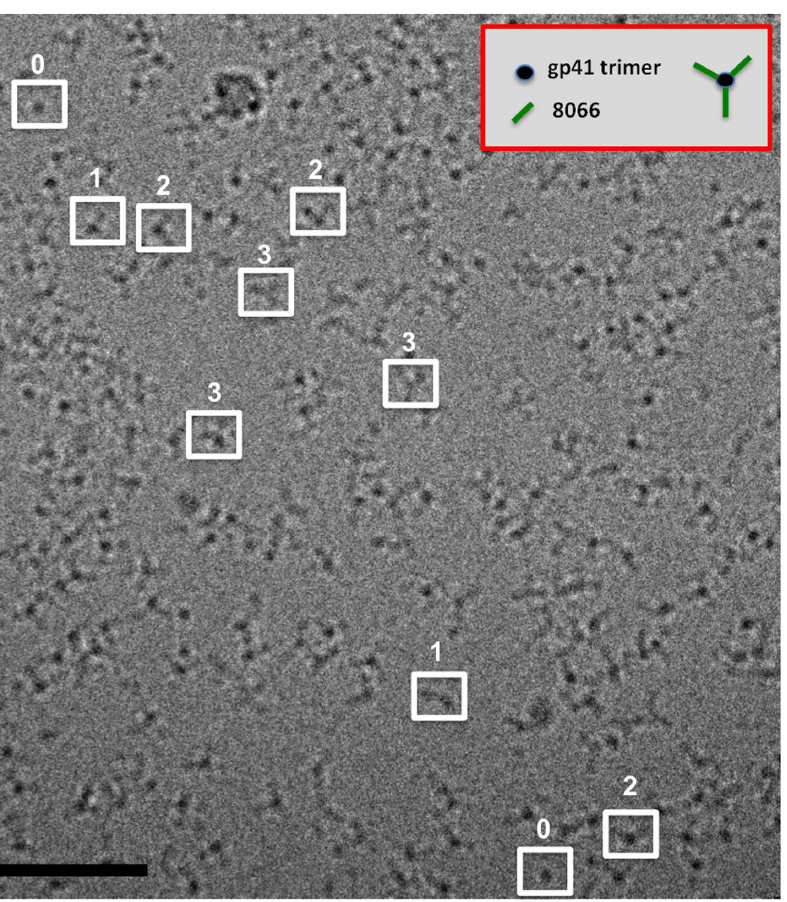
Figure 3. Projection cryo-electron microscopic image from specimens of gp41-Fab 8066. The complexes were vitrified at a concentration of , 0.2 mg/ml. Examples of putative complexes with Fab occupancies of 0, 1, 2, or 3 are highlighted in the boxed regions. Data were collected on an FEI Titan Krios electron microscope, operated at 80 kV, with the images recorded on a Falcon II direct electron detector. The black bar corresponds to 50 nm.